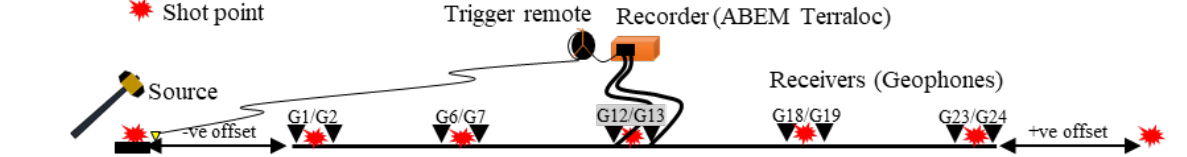
Figure 3. Schematic diagram of seismic refraction.